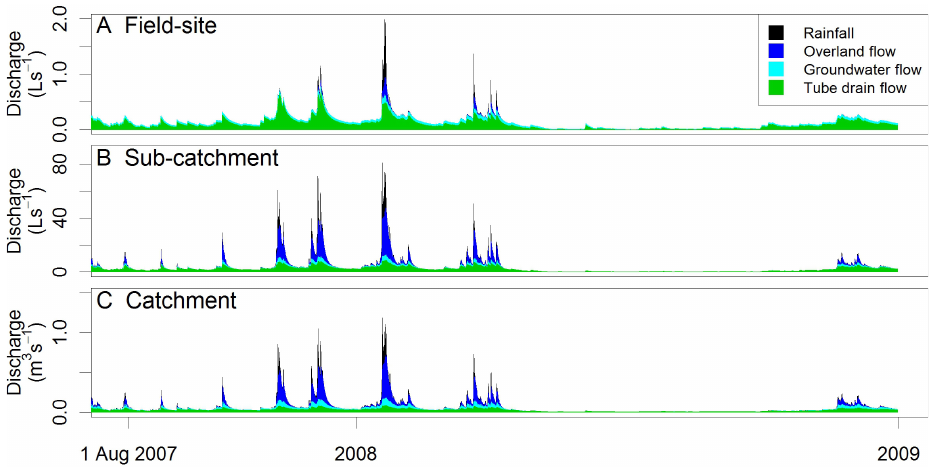
Fig. 8. Contributions of flow routes to total discharge. The displayed contribution is the median of contribution of all behavioral parameter sets (BPS-N). Table 4. Calculated flow route contribution (0.1–0.9 quantiles) of BPS-N and BPS-C. The contribution is calculated over the period Novem- ber 2007 through December 2008.